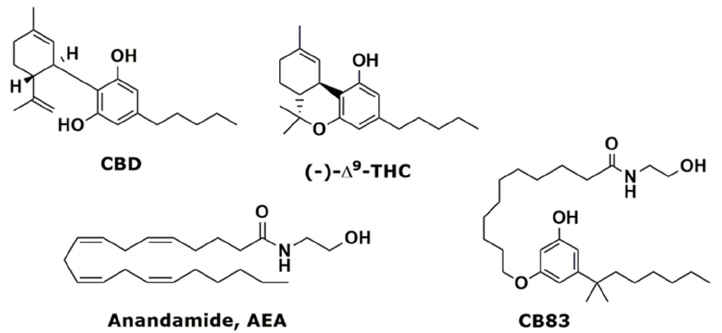
Figure 1. Phytocannabinoids cannabidiol (CBD), ∆ 9-tetrahydrocannabinol ( ∆ 9 -THC), endogenous anandamide (AEA), and synthetic cannabinoid